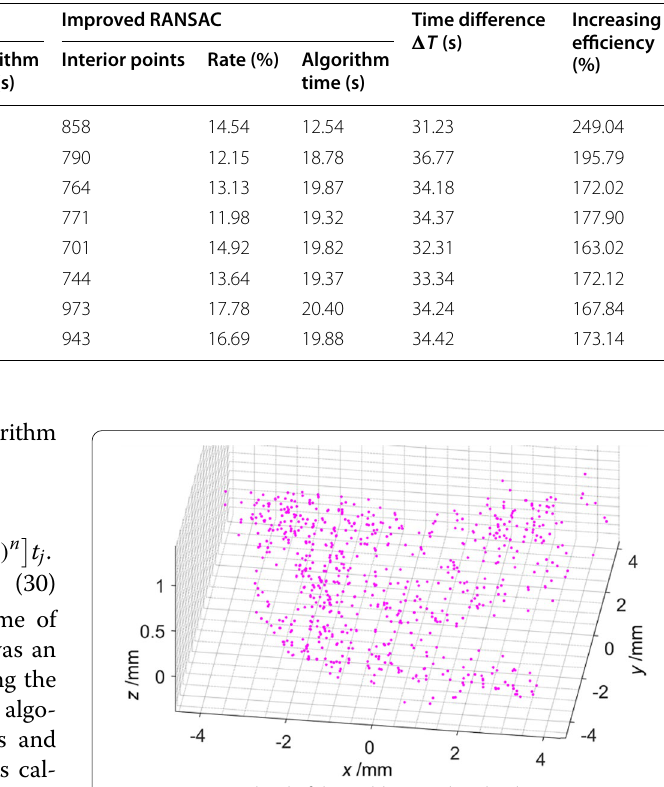
Figure 15 Point cloud of the welding pool under the